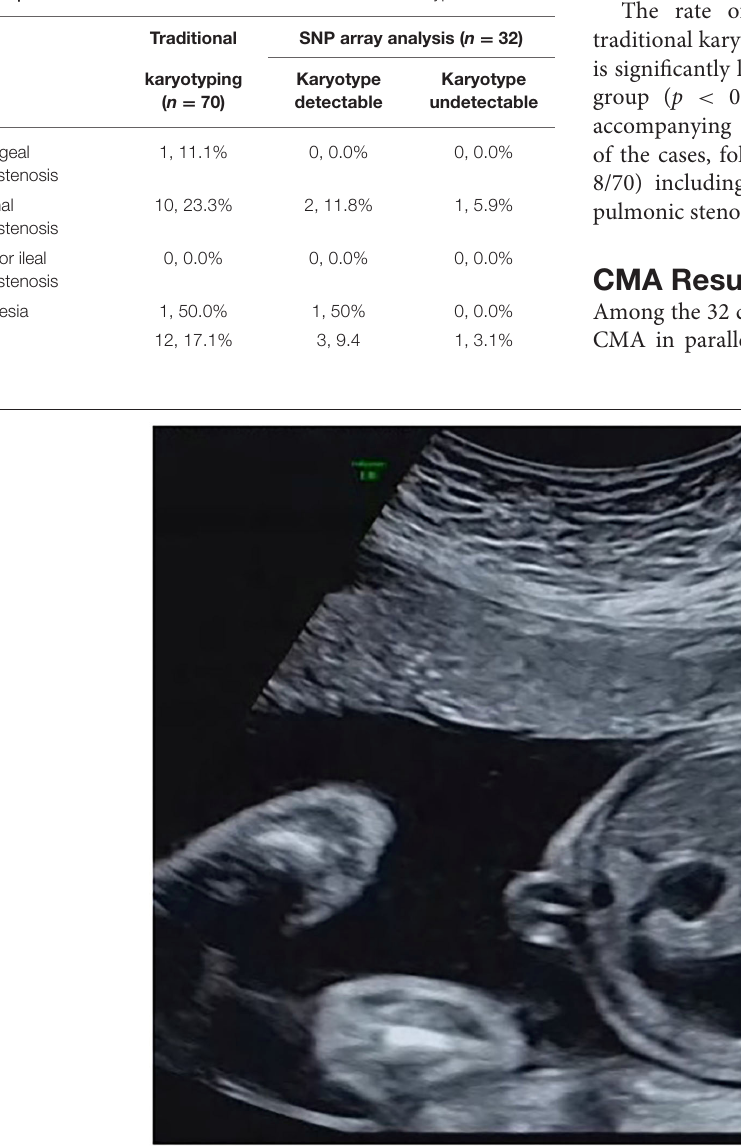
TABLE 3 | Distribution of chromosomal abnormalities in different types of GITO.